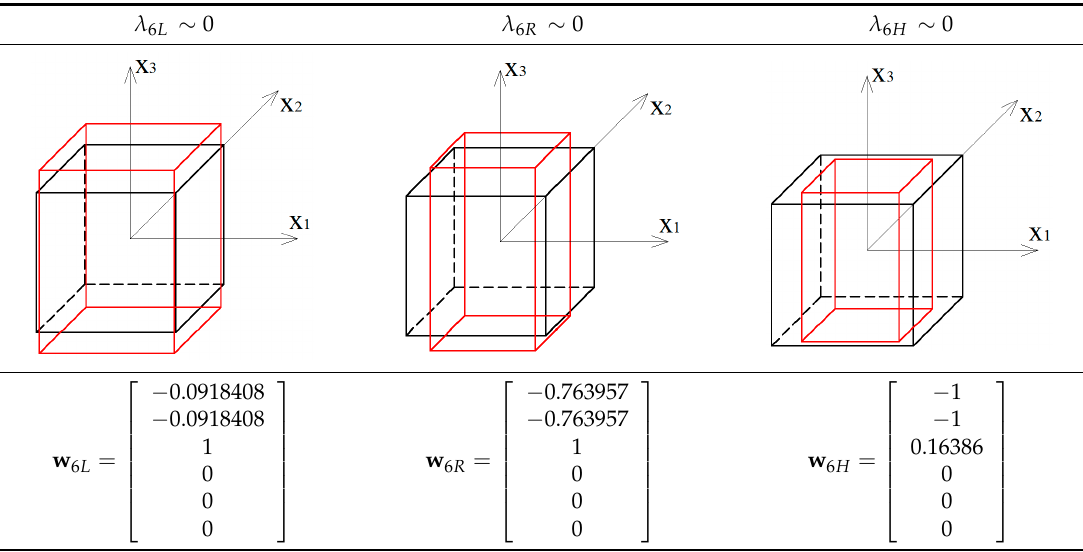
Table 2. Soft (extensional) mode of deformation.